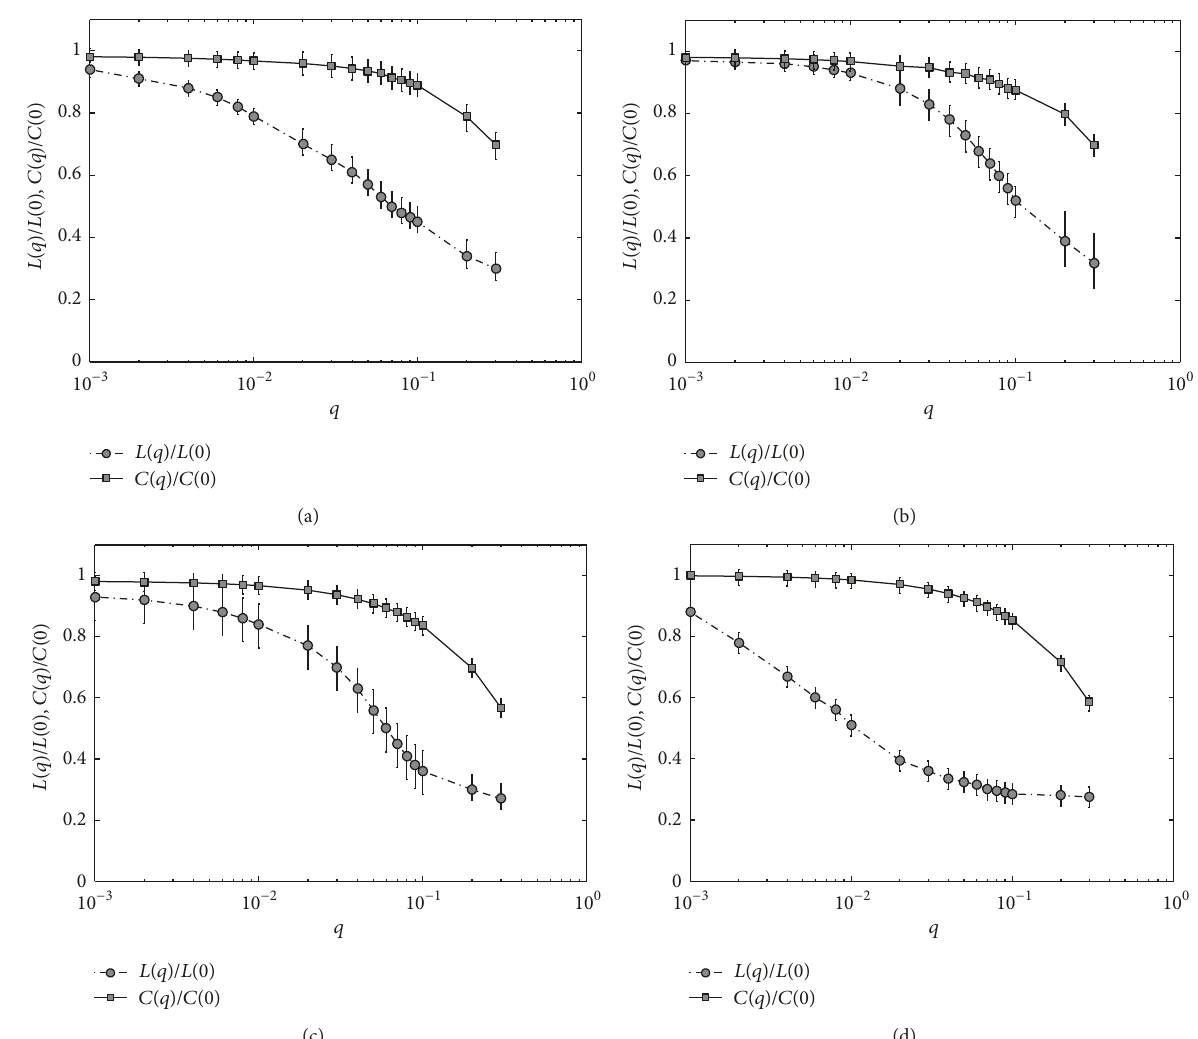
Figure 3: Analysis of average path length and clustering coefficient under different establishing schemes of shortcuts. (a) Scheme RC. (b) Scheme SC. (c) Scheme RCS. (d) Scheme